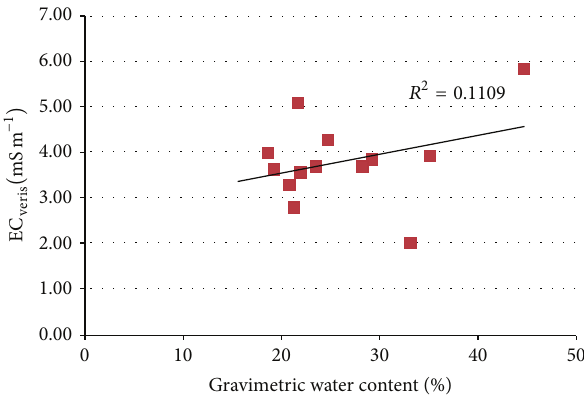
Figure 4: Correlation between EC